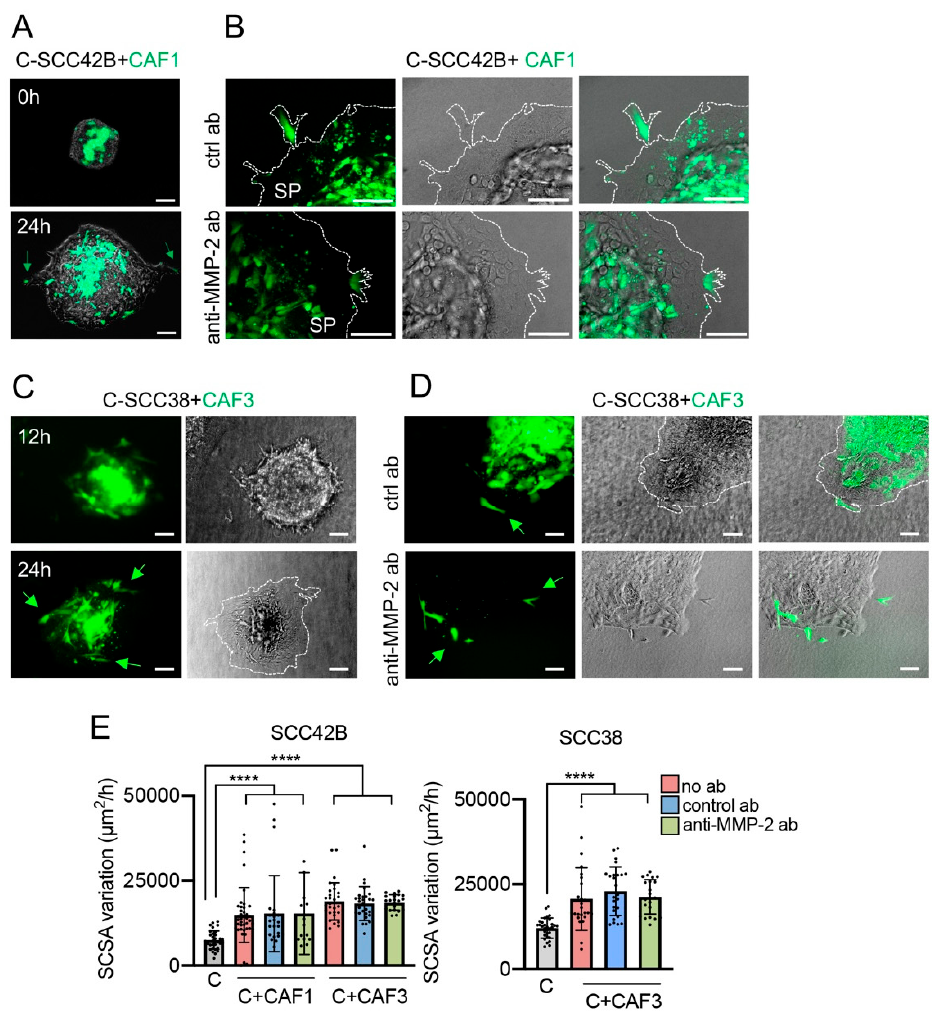
Figure 3. Effect of anti-MMP-2 antibodies on the collective migration of mixed SCC + CAF spheroids. ( A , D ) Representative images of mixed spheroids containing control (C-SCC42B or C-SCC38) cells and CMFDA-labelled CAFs and incubated for 0, 12 or 24 h in the absence of antibodies ( A , C ), or in the presence of control anti-SDHB (ctrl ab) or anti-MMP-2 antibodies ( B , D ). In panels ( B – D ), bright field and fluorescence images of the same spheroids are shown. (E) Variations over time of the SCSA of the spheroids assembled with C-SCC or C-SCC + CAF. Data are presented as mean ± standard deviation from 3 individual experiments; at least, 15–30 spheroids were used for quantifications. SP, spheroid. Scale bars, 100 µm. **** indicates p < 0.0001.